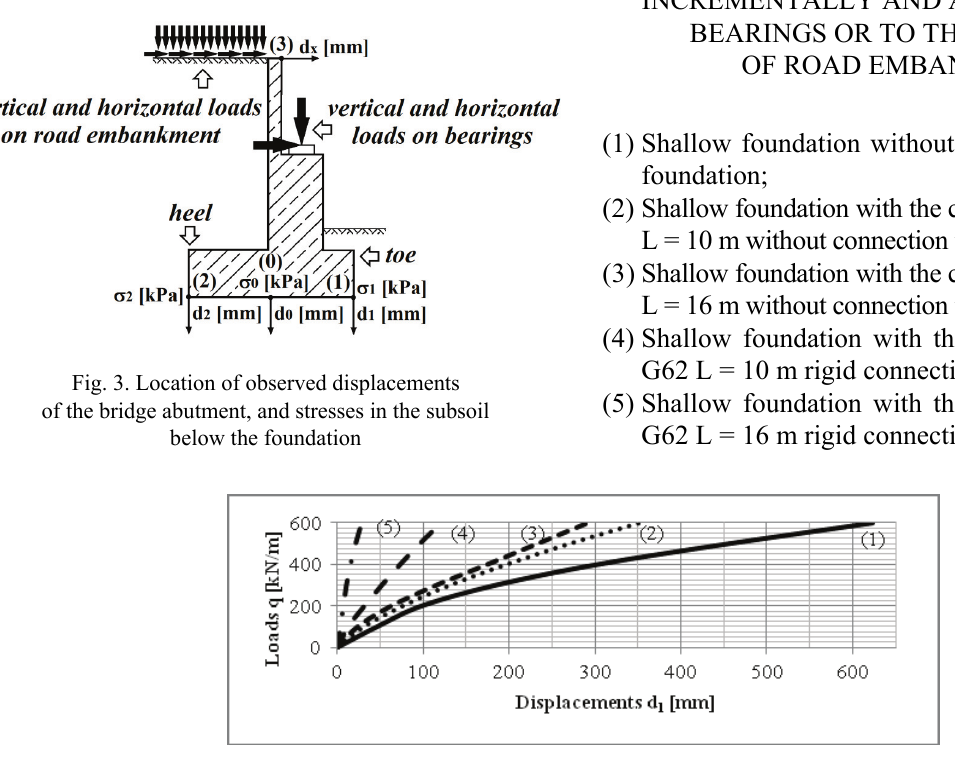
Fig. 4a. Displacements d 1 (mm) depending on the use of sheet piles as a cover of the foundation. Vertical load applied at the bearing